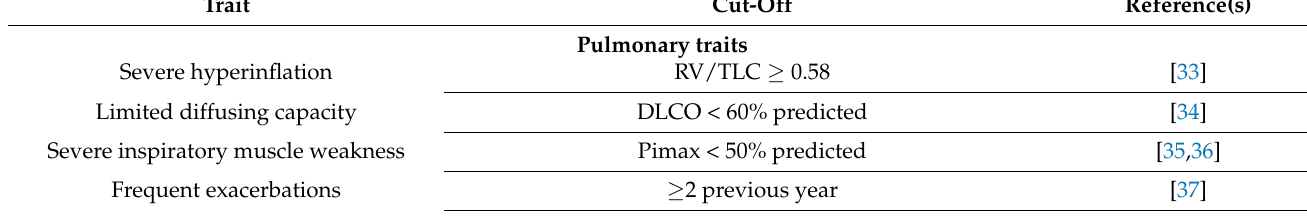
Table 1. Cut-off values used to identify pulmonary, extra-pulmonary, and behavioural traits in people with chronic obstructive pulmonary disease.